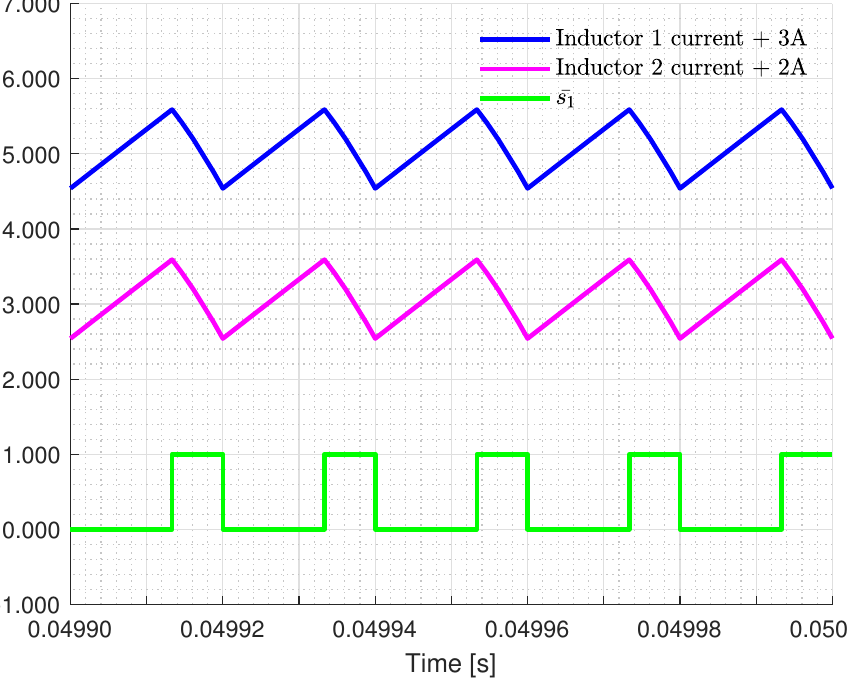
Figure 17. From the top to the bottom: inductor current i L 1 (blue trace), inductor current i L 2 (pink trace), and switching signal ¯ s 1 (green trace) of